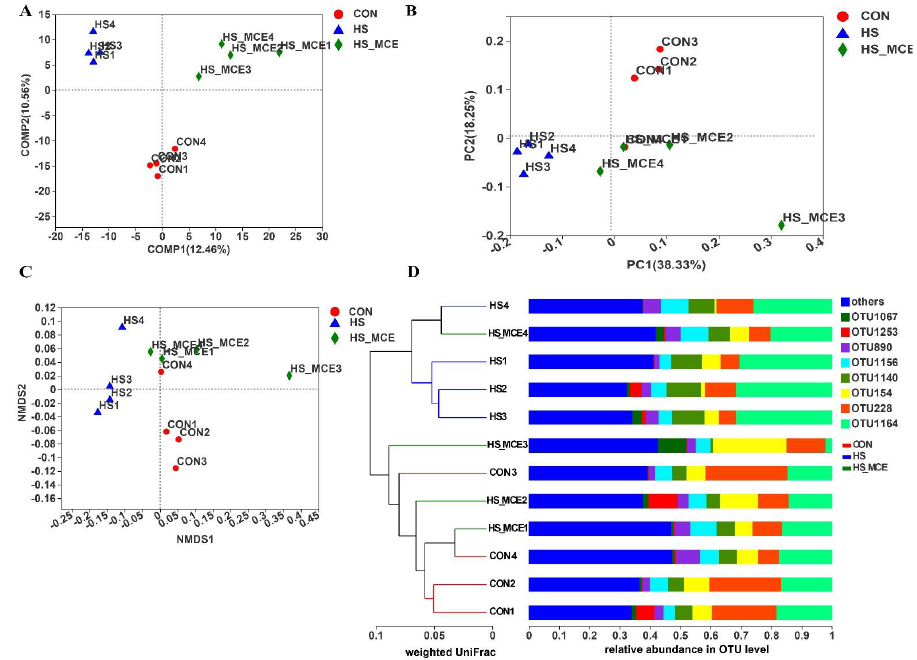
Figure 5. Cecal bacterial Beta diversity of yellow-feathered broilers. ( A ) PLS − DA analysis. ( B ) PCoA analysis. ( C ) NMDS analysis. ( D ) Hierarchical cluster analysis. Abbreviations: CON, control group; HS, heat stress group; HS-MCE, Heat Stress plus MCE group.